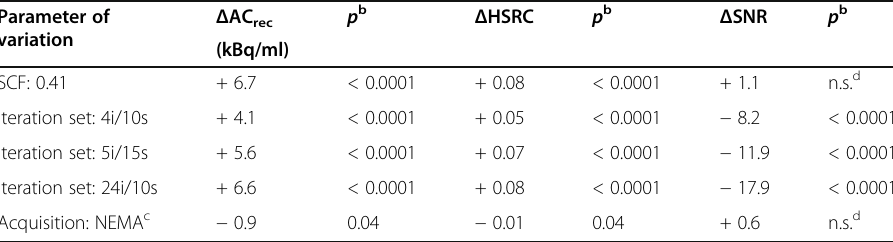
Table 2 Effect of examined parameters on AC rec , HSRC and SNR. The results are exemplified for the largest sphere volume in comparison to a reference protocol a .